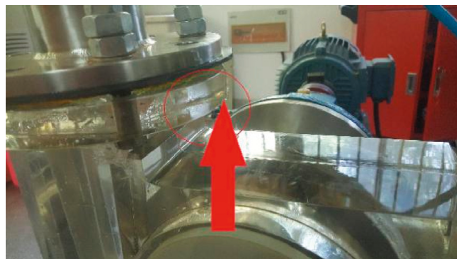
Figure 23: Location of pump shell crack.